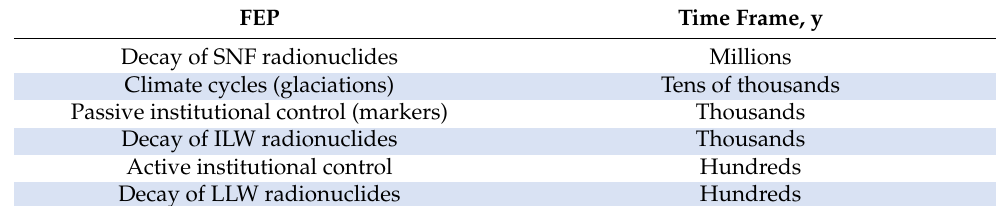
Table 3. Expected time frames of FEPs in